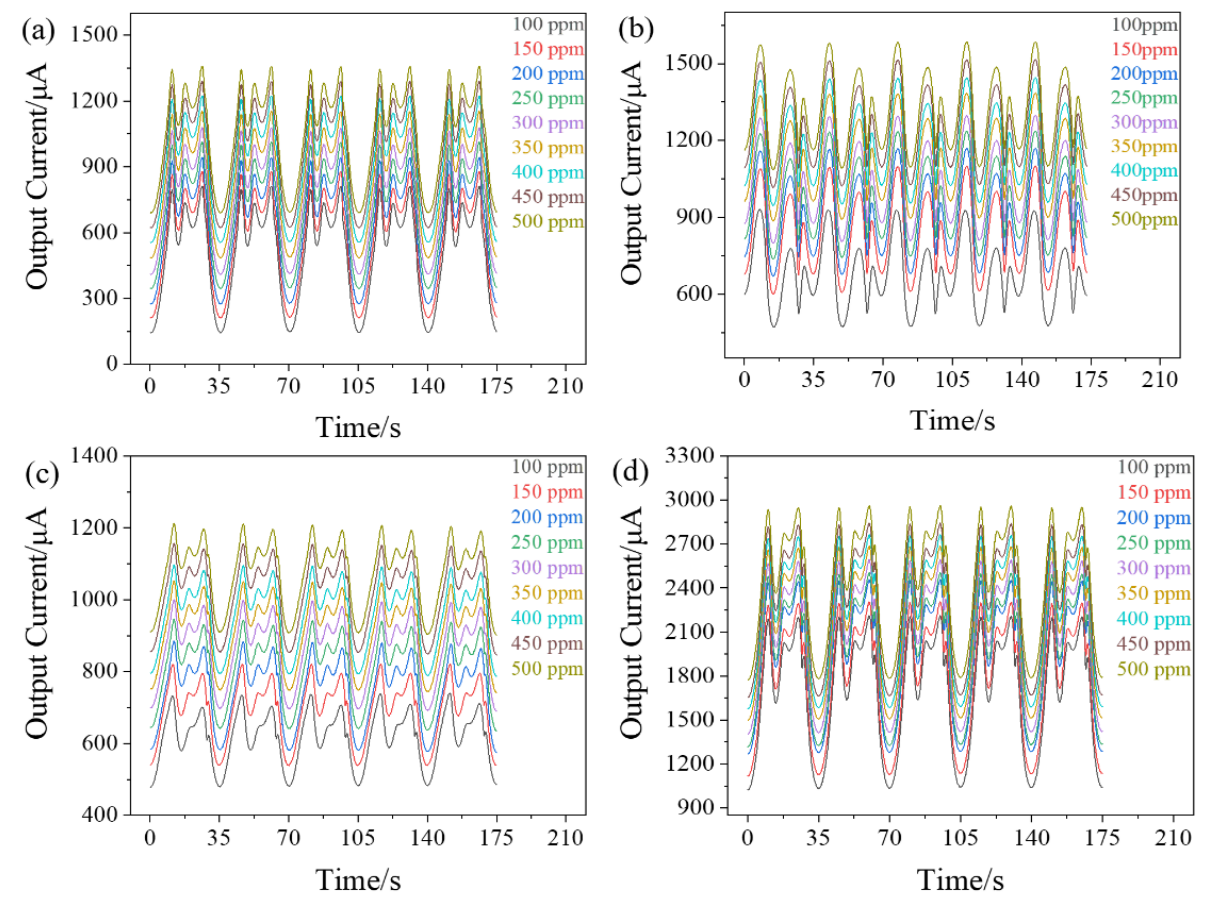
Figure 11. The 100–500 ppm concentration gradient curve under TW-3 of four alcohol homologues gases. ( a ) ethyl alcohol ( b ) n-propyl alcohol ( c ) isopropyl alcohol ( d ) n-butyl alcohol.